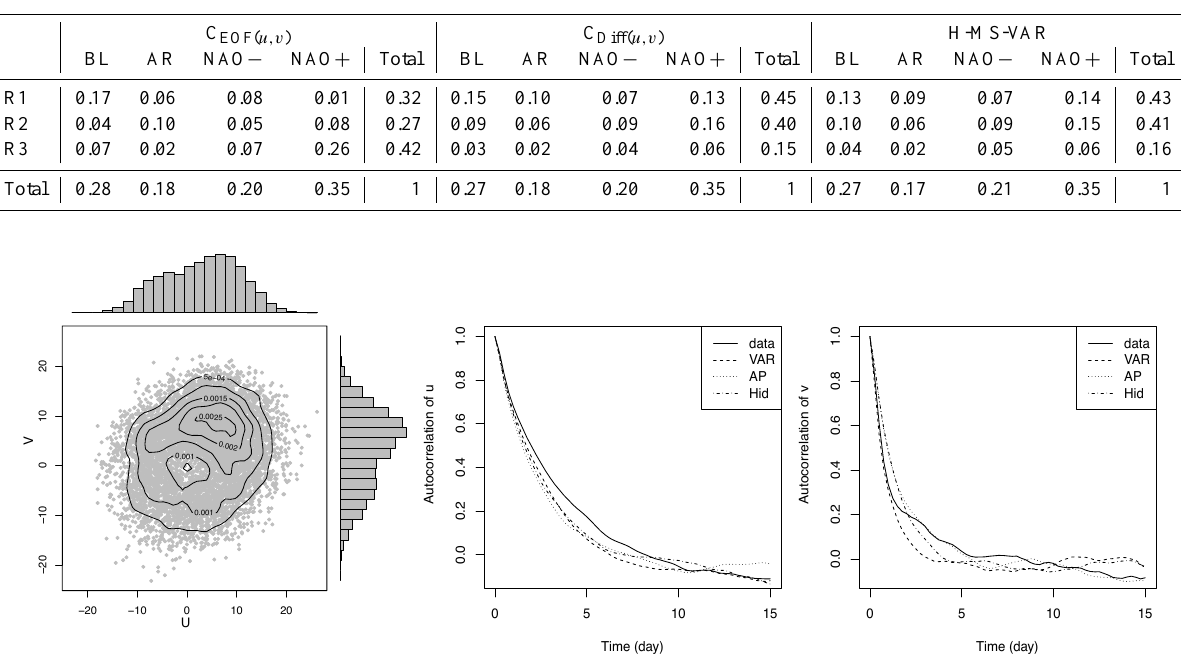
, and H-MS-VAR Diff( u,v )